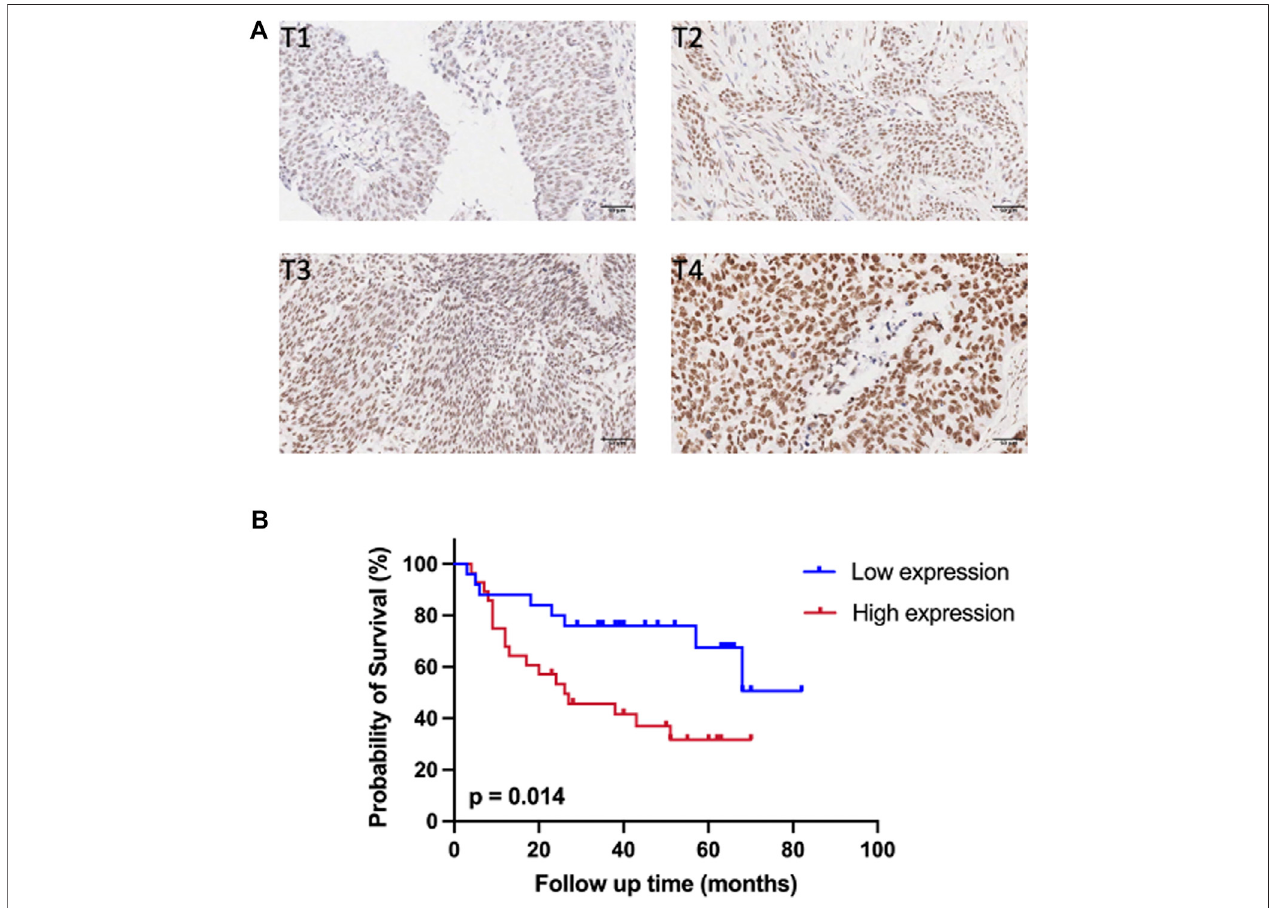
FIGURE 3 | The expression of SMARCC1 was closely related to T stage and survival of patients with BC. (A) Representative images of SMARCC1 staining in paraf fi n-embedded BC tissues of stage T1-T4. The IHC analysis revealed that SMARCC1 was localized mostly in the nucleus in BC specimens, and the positive percentageandintensityofSMARCC1staininginBCweregraduallyelevatedalongwiththeTstageincreased. (B) TheKaplan-Meiermethodwasappliedtoanalyzethe overall survival of BC patients. The survival rate of patients with low SMARCC1 expression was signi fi cantly higher than that of patients with high SMARCC1 expression (log-rank test; p =